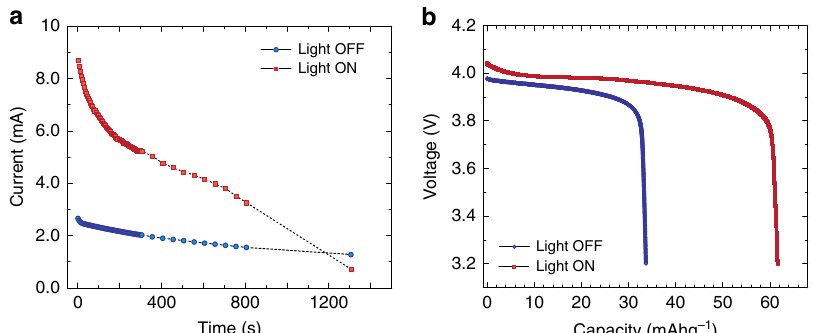
Fig. 2 Electrochemical performance of the light accepting ‘ open ’ lithium-ion battery cell. Li ││ 1.2 M LiPF 6 ; EC:EMC 3:7 (w:w) ││ LMO (EC = ethylene carbonate; EMC = ethyl methyl carbonate). a Chronoamperometry curves for ‘ light-on ’ vs . ‘ light-off ’ state during constant voltage hold charging at 4.07 V ( vs . Li + /0 ) for approximately 22 minutes. b Constant discharge curves carried out without illumination after the chronoamperometry experiment shown in a (voltage pro fi les at C/10). The “ light-on ” experiments were carried out under 1 SUN (100 mW/cm 2 ), a white light is used with an IR fi lter to avoid undesired heating of the cell. The heat effect in control experiments are presented in Supplementary